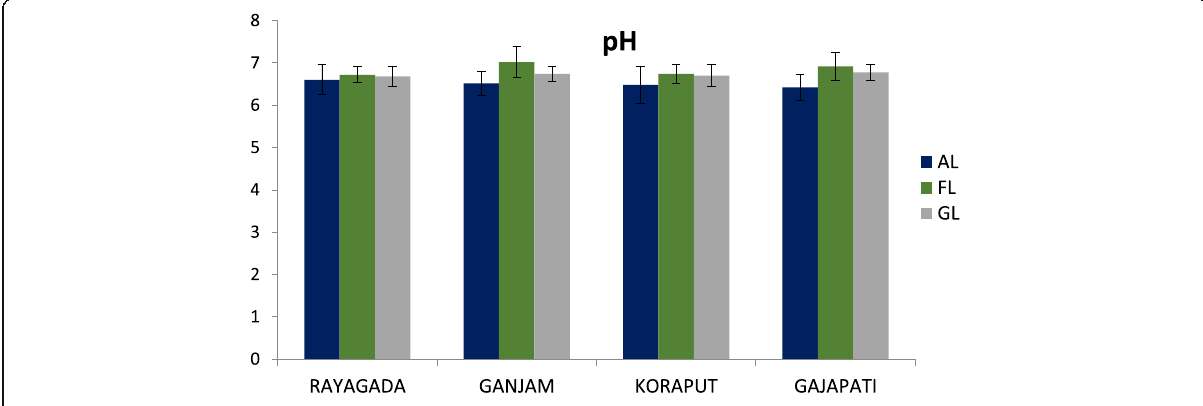
Fig. 7 Soil pH of different land use patterns across four